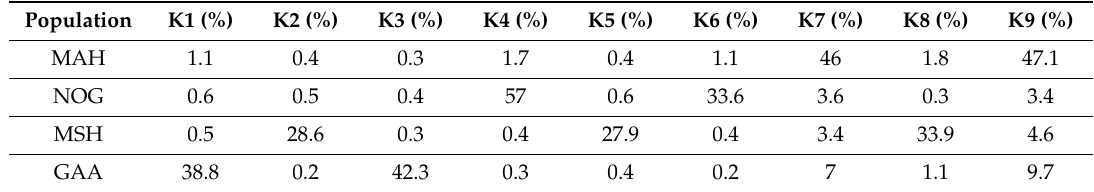
Table A5. Proportion of genetic clusters for each locality in STRUCTURE analysis among invasive A. franciscana